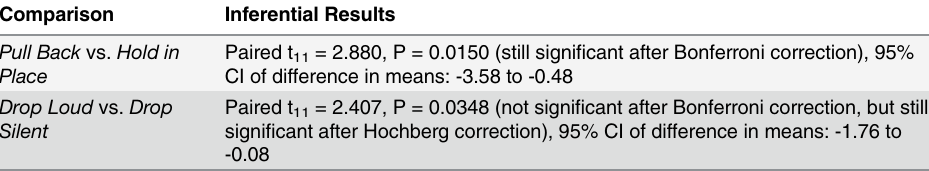
Table 4. Inferential